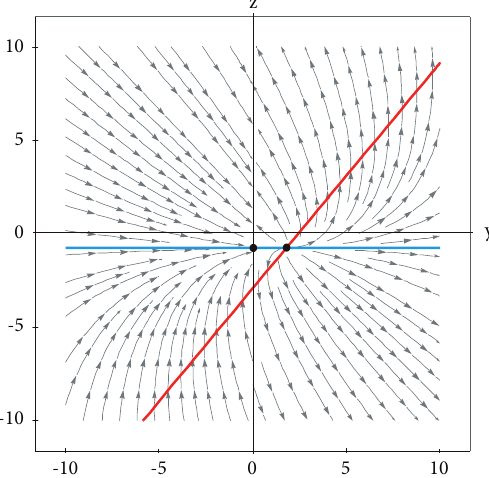
Figure 7: Phase plane of system (9) for 0 ≤ R < ρ , with R ≃ 0 . 292 ( β ′ � 0 . 05 ) ; the other rates are δ � 0 . 071, α � 0 . 1, and σ � 0 . 17. The vector 0 0 1 field and some trajectories are indicated by lines and arrows in gray. Two nullclines are shown: one horizontal (blue line) and other vertical (red line); the horizontal and vertical remaining pair coincides with the z -axis. The disease-free equilibrium point E and the endemic E ∗ ≃ ( 1 . 776 , − 0 . 776 ) is an unstable node of two “straight-line” solutions; both points are indicated by a black